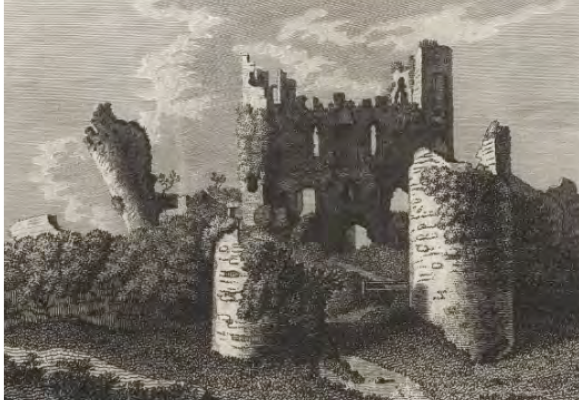
Figure 2. Caerphilly or Sengenneth Castle Pl2